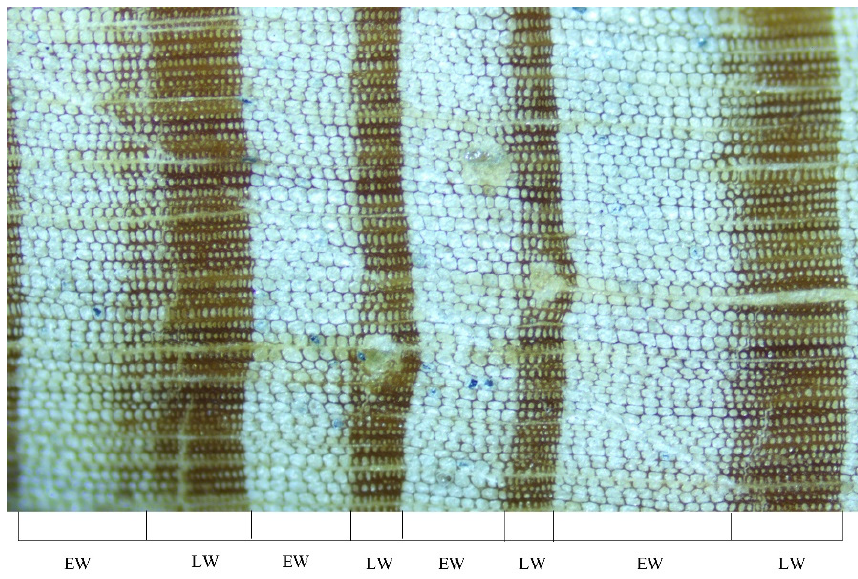
Figure 2. The boundary diagram of EW and LW of Pinus taiwanensis Hayata under a microscope, magnification of 200 times.